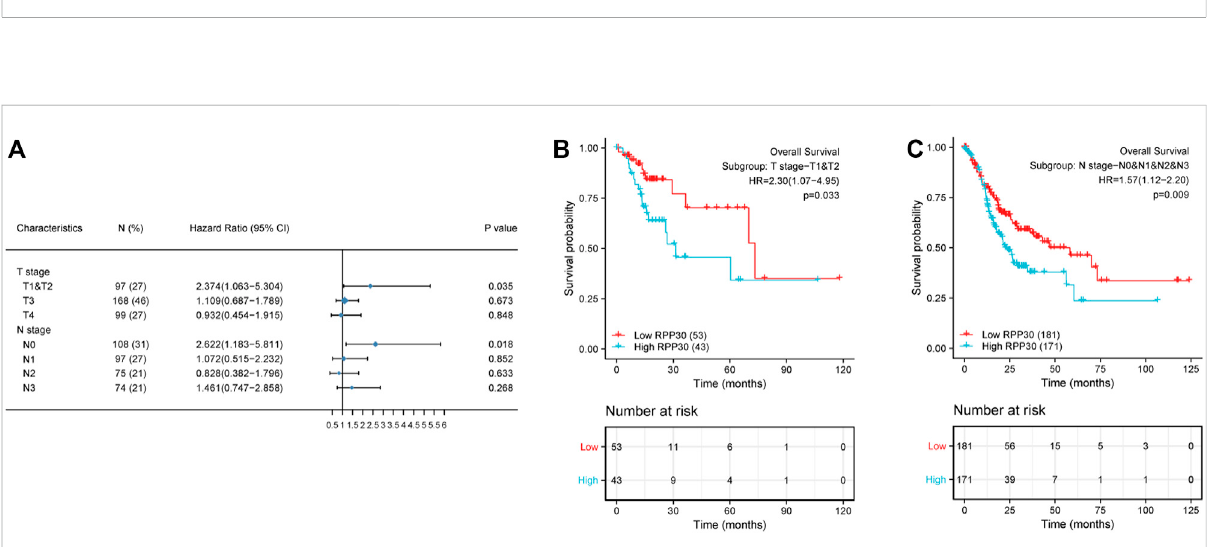
FIGURE 7 Subgroup survival analysis of clinical characteristics of GC. (A) High RPP30 expression was correlated with worse OS in the T1 and T2 stages of GC, but not in the T3 and T4 stages. In the N stages, high RPP30 expression was associated with worse OS in the N0, but not in the N1 - N3 stages of GC. (B) The K-M plot of OS showed that high RPP30 expression had higher HR value (HR = 2.3, p = 0.033) in subgroups of T1 and T2 stages. (C) The hazard ratio in the high-RPP30 expression group was 0.57 times higher than that in the low expression group ( p =